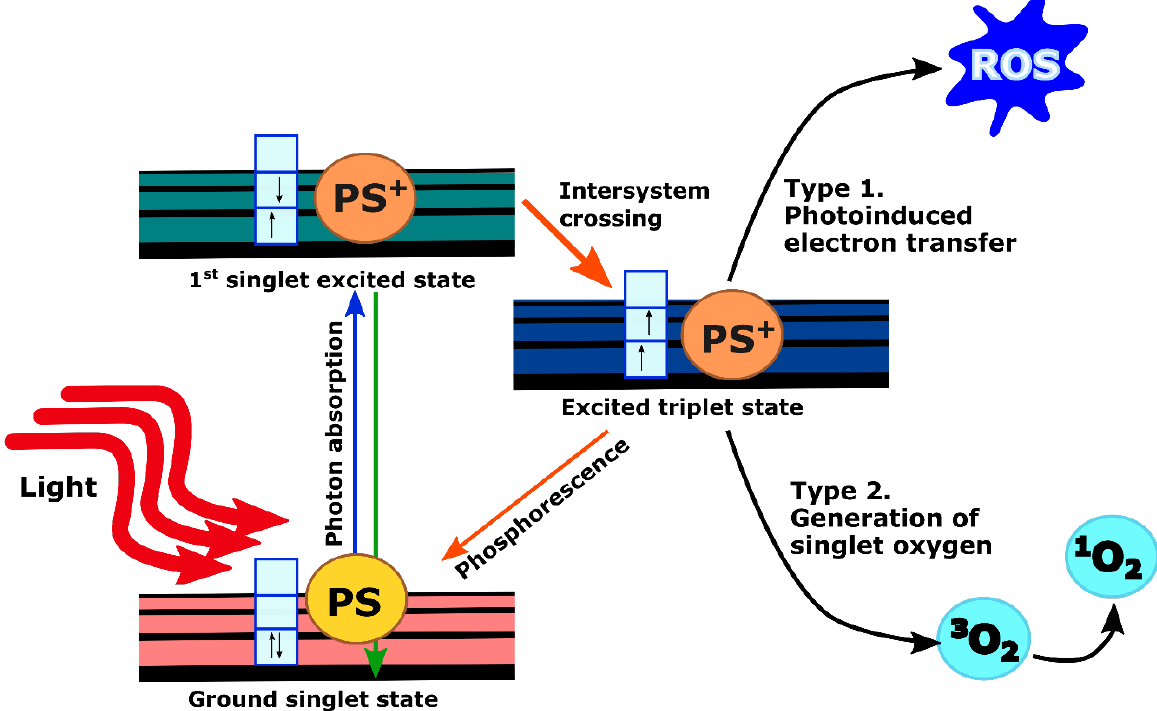
Figure 2. Photophysics and photochemistry of PDT. Vertical arrows in boxes indicate electron spin states. PDT does offer several inherent advantages. Depending on the localization of the PS, PDT can directly damage or alter targets in tumor cells. Additionally, since the visible or near infrared light used in PDT is non-ionizing, PDT does not carry the accumulating toxicity associated with radiotherapy [12,23]. However, unlike ionizing radiation, a noted challenge with PDT is the limited penetration of red and near-infrared wavelengths in tissue. Light delivery for internal sites such as the pancreas requires careful treatment planning and dosimetry, though innovative solutions have been developed and clinically validated as discussed further